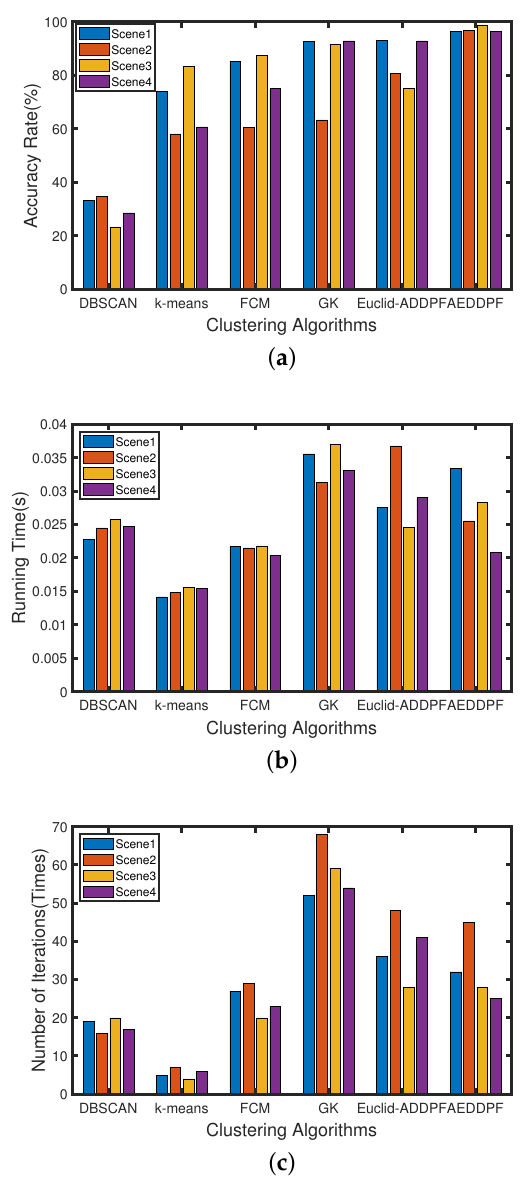
Figure 11. Histogram comparison of clustering results of different clustering algorithms in four radar scenes: ( a ) Average Accuracy ( % ) ; ( b ) Average Running Time ( s ) ; ( c ) Average Number of Iterations ( Times )